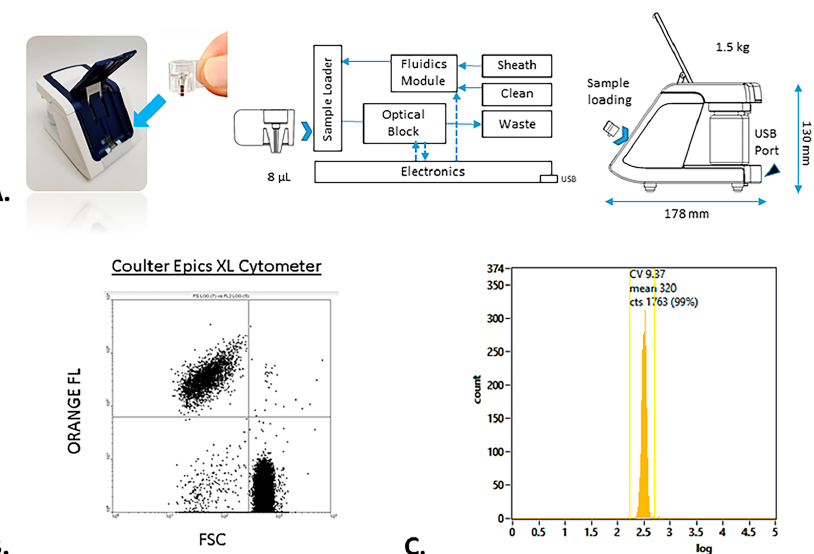
Figure 4. Overview of the rHEALTH method for microvolume cytometry analysis of platelets and data from benchmark cytometer and rHEALTH. ( A ). Left, 8 µ L capillary blood sample in a clear plastic consumable is loaded into the instrument for analysis. Middle, The sample consumable is received by a plunger-based, in-line sample loader which seals around its two open ends. Pressure (~70 mbar) is applied to the system which drives the entire sample volume, via hydrodynamic focusing, into a miniaturized optical module for laser-based cytometry detection. A fluidics module with electronic valves manages fluids from the pressurized sheath and clean bottles (60 cc). The analyzed sample passes through the optical block and into the removable waste bottle (60 cc). The electronics with embedded software manage instrument control and data capture. Dashed lines indicate connection to the optical and fluidics modules. Arrows from the electronics module indicate a control function and arrows to the electronics indicate a data function. The USB provides power, control commands, and data output to and from a PC. Right, The device is shown in its side view with dimensions, mass, USB 2.0 port, and sample loading orientation. ( A ). PC computer (not shown) provides power (up to 2.5W) via the USB connection, collects raw data, and performs data analysis. ( B ). XY scattergraphs generated by Coulter cytometer in quadrant analysis. ( C ). rHEALTH histogram analysis of total platelet count includes all orange fluorescent events. Reprinted with permission from [27]. Copyright 2021